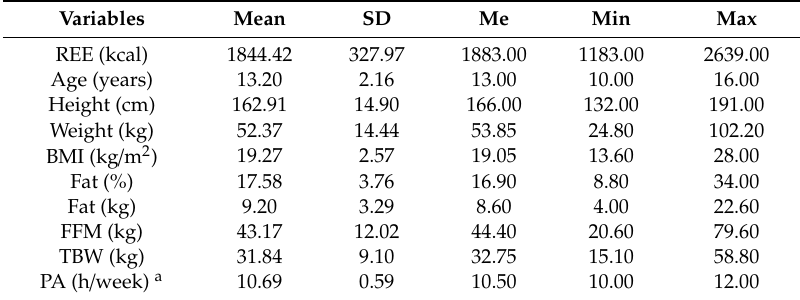
Table 1. Characteristics of the study